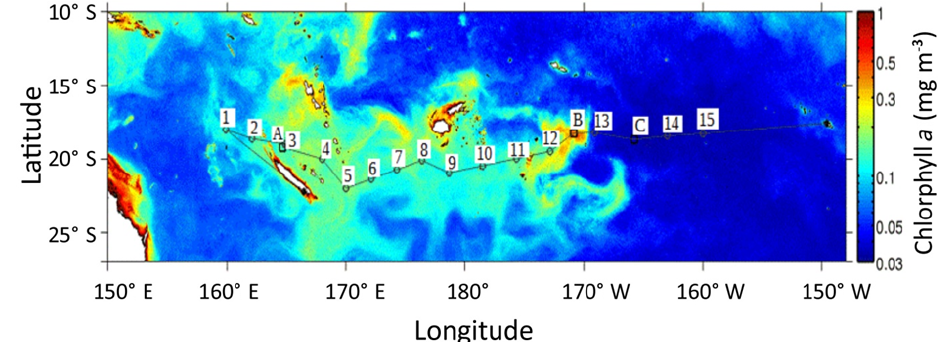
Figure 1. Map of chlorophyll distribution during the OUTPACE cruise (image composite of the Moderate Resolution Imaging Spectrora- diometer – MODIS) data provided by CLS, Collect Localization Satellites). The positions of the 15 stations are shown by numbered squares, with A, B and C representing long-duration stations (7 days), A in the Melanesian archipelago, B in the Fijian archipelago, C in the western part of the South Pacific